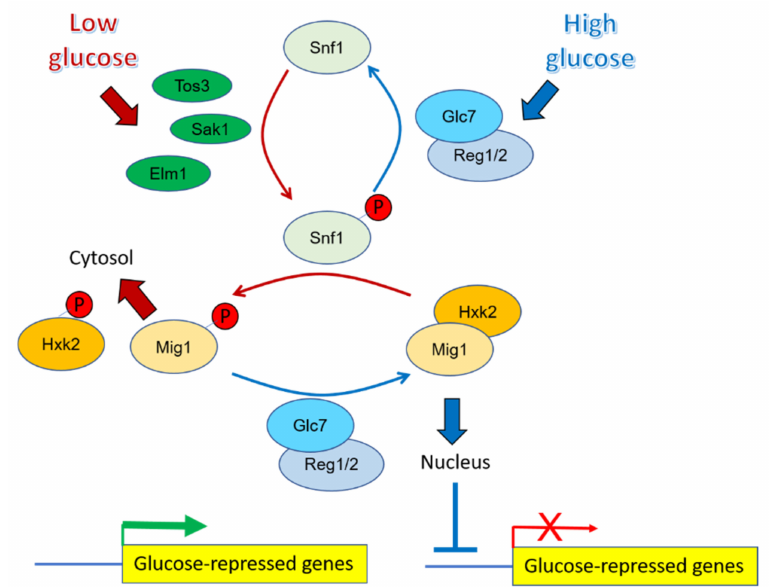
Figure 2. Simplified representation of known phosphorylation mechanisms regulating the transcrip- tional repressor Mig1 under high and low glucose conditions. The model has been drawn based on data extracted from references